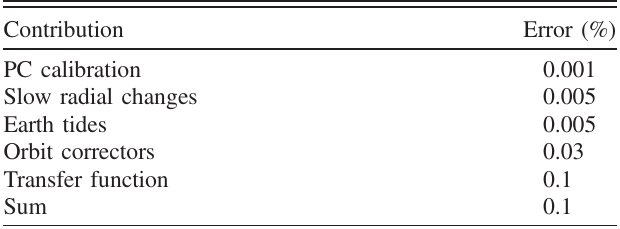
TABLE IV. Table of relative errors to the LHC beam energy above injection